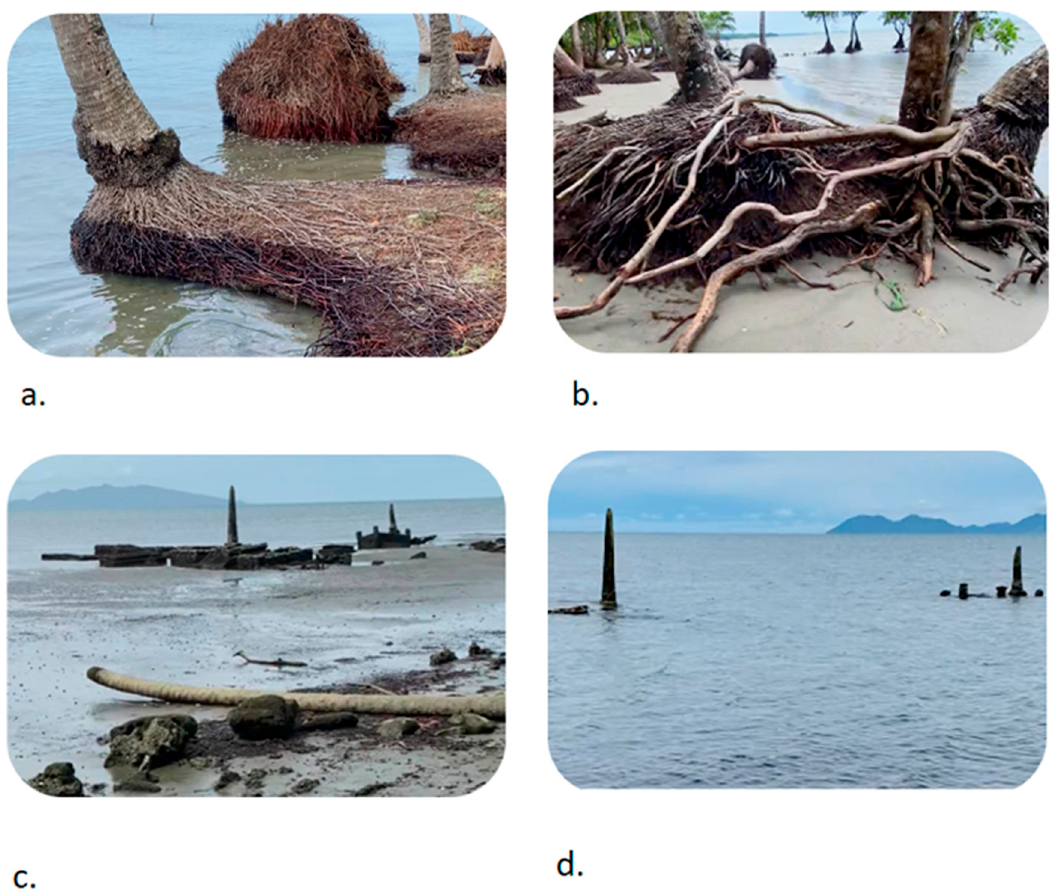
Figure 3. Images of coastal hazards. ( a ) Coastal erosion; ( b ) Exposed roots; ( c ) Graveyard at low tide; and ( d ) Submerged graveyard at high tide (Photo Credit: Yee, 2021).